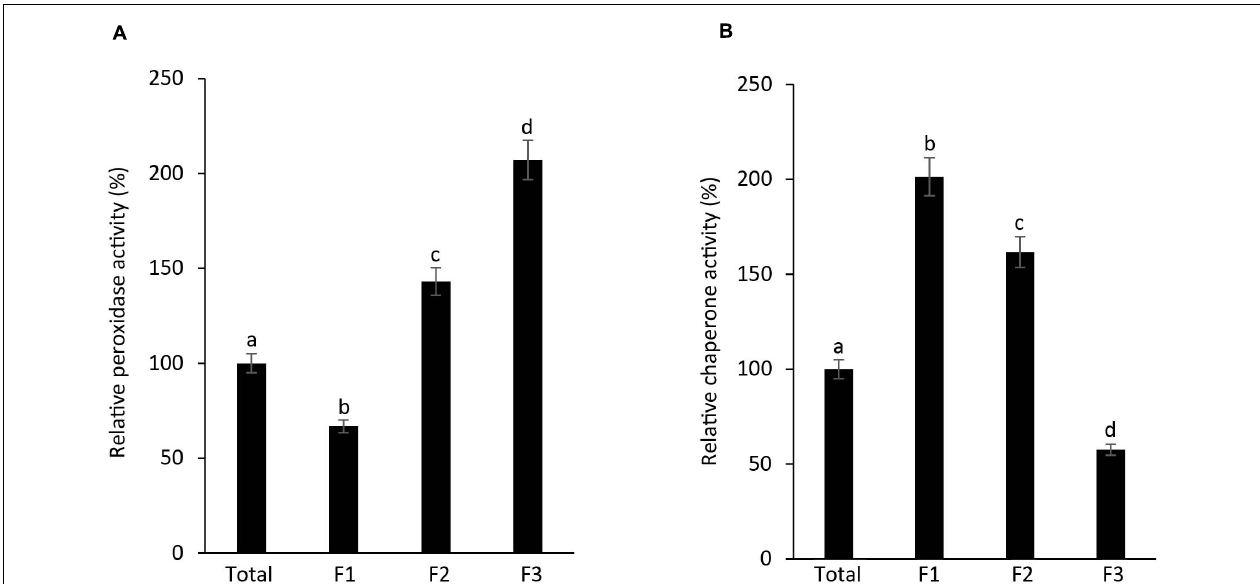
FIGURE 3 | AtAPX1 functions are related to differently sized protein structures. We separated the AtAPX1 protein into three fractions corresponding to the HMW complexes (F1), the LMW form (F2), and the dimeric form (F3). (A) Peroxidase activity of fractions was assayed by monitoring the reduction of ascorbate at 290 nm. (B) Chaperone activity was evaluated using a 1:1 molar ratio of MDH and AtAPX1. The activities of the three AtAPX1 protein fractions were compared with those of total protein which was set to 100%. Data are means ( ± ) standard deviation of three independent experiments. Different letters indicate significant differences at P < 0.05 between the total protein and fractions by one-way ANOVA with Tukey’s test.